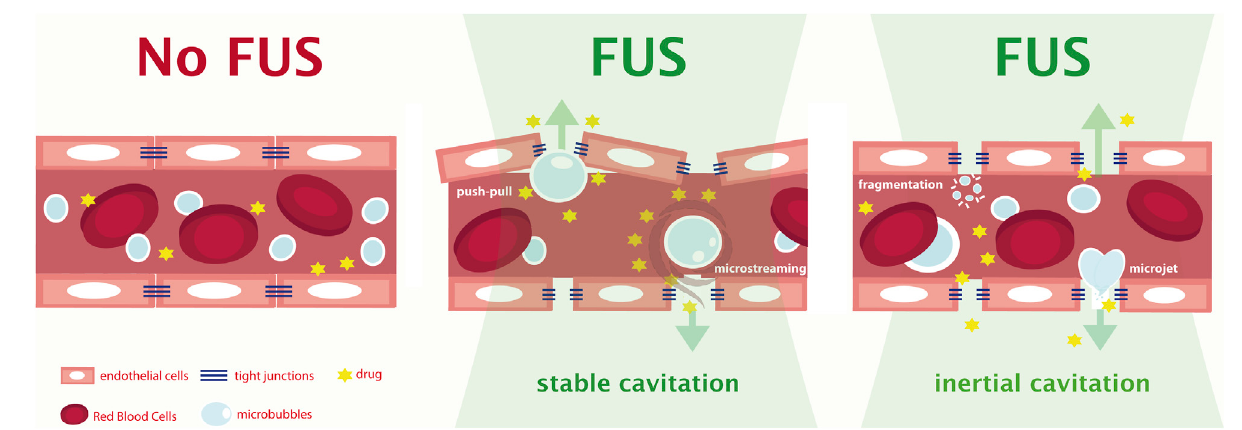
FIGURE1| Schematicrepresentation ofterminalcapillaries targeted bytheFUS stream. IntheabsenceofFUS-induced cavitation, anintact BBBofalivinganimal (No FUS) with fl owing red blood cells and peripherally (tail vein) injected microbubbles is depicted. Upon FUS stimulation and depending on the speci fi c combination of acoustic pressure and frequency applied, a controlled stable cavitation with a balanced microbubbles expansion and compression or an inertial cavitation with a wide range of microbubbles diameters may be achieved by the operator at speci fi c brain point locations. Both mechanisms leading to stretching of tight junctions in the endothelialcellsofthe fi nalcapillaryallowinga15 ′ -12 hwindowofBBBopening anddrugsdeliverytoadjacentbrainparenchyma. Incaseofstablecavitationconditions microbubblesinducetheopeningofthecapillarywallsmainlythroughpush-and-pullmechanismsand/orlocalmicrostreamingoftheblood fl ow.Ifinertialcavitationtakes place, microbubbles become unstable and collapse emitting high energy microjets or more rarely explode (fragmentation), in both cases facilitating the drug passage through the BBB, however often resulting in local in fl ammation/oxidative